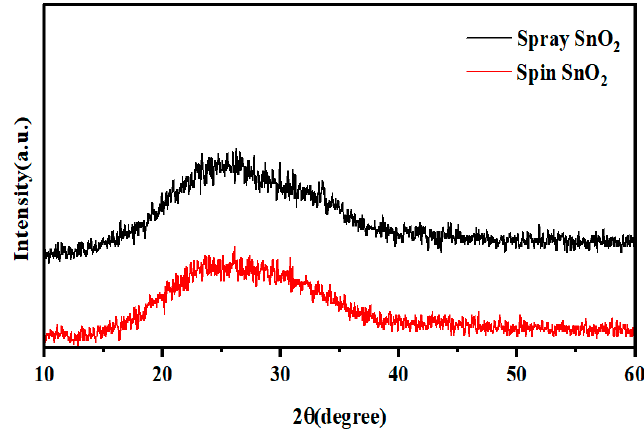
Figure 2. XRD patterns of spin-coated and sprayed SnO 2 films.